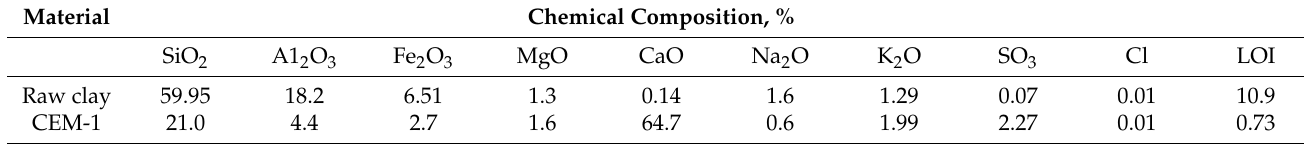
Table 1. XRF of raw